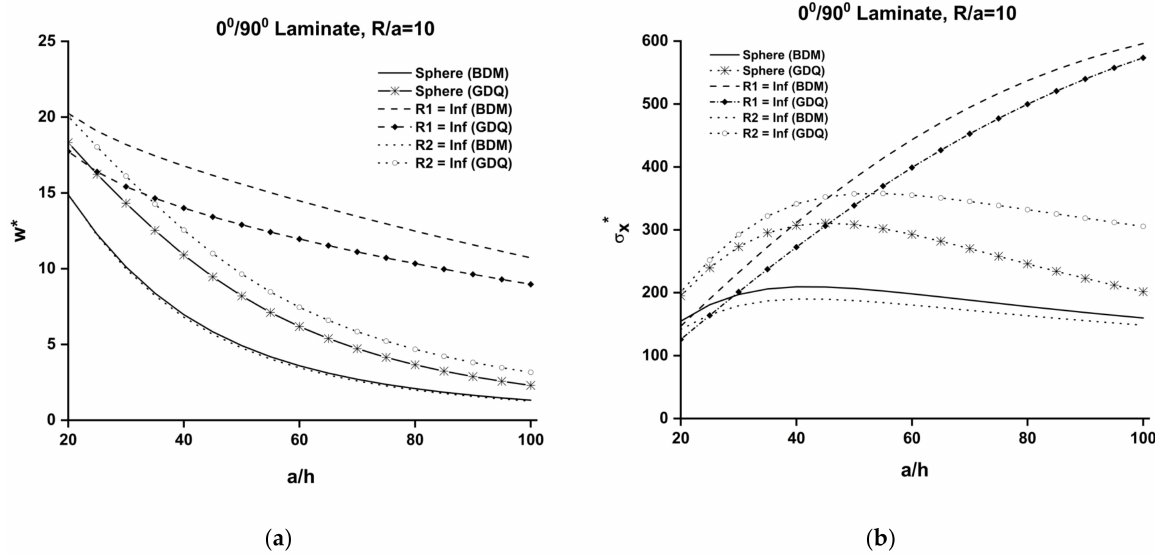
Figure 3. ( a ) Variation of the non-dimensional displacement, w ∗ , and ( b ) non-dimensional stresses, σ x ∗ , with a / h ratio for antisymmetric [0 ◦ /90 ◦ ] spherical and cylindrical panels (R/ a =